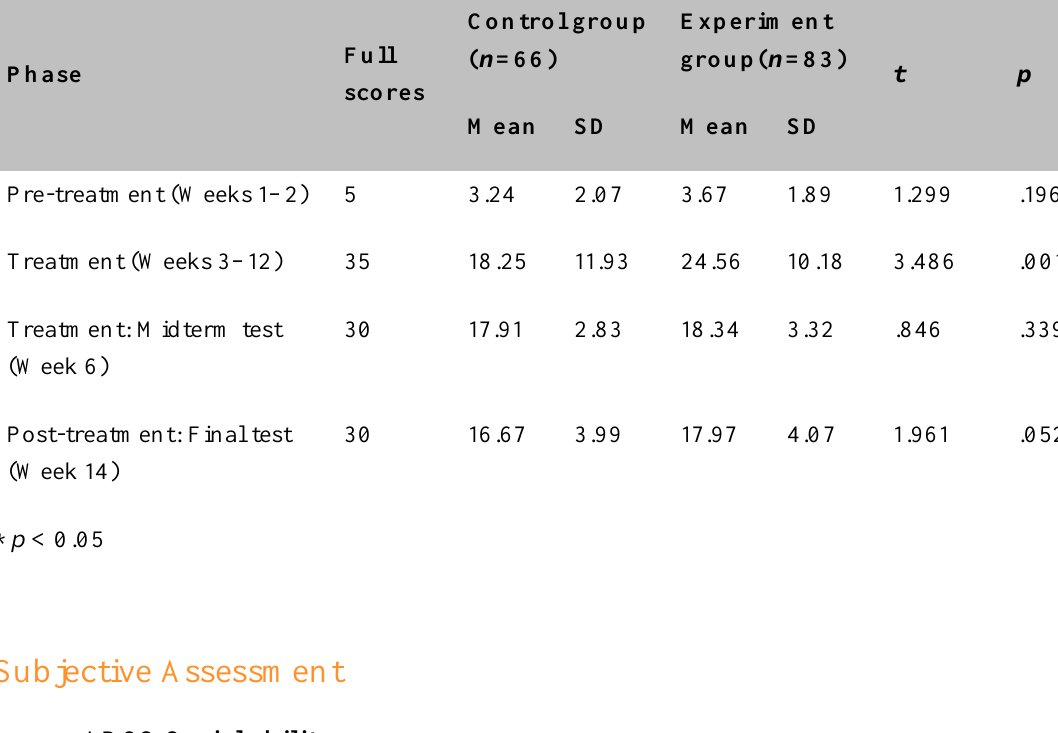
Descriptive Statistics and T-Test Results for Average Scores on Assignments, Midterms, and Final